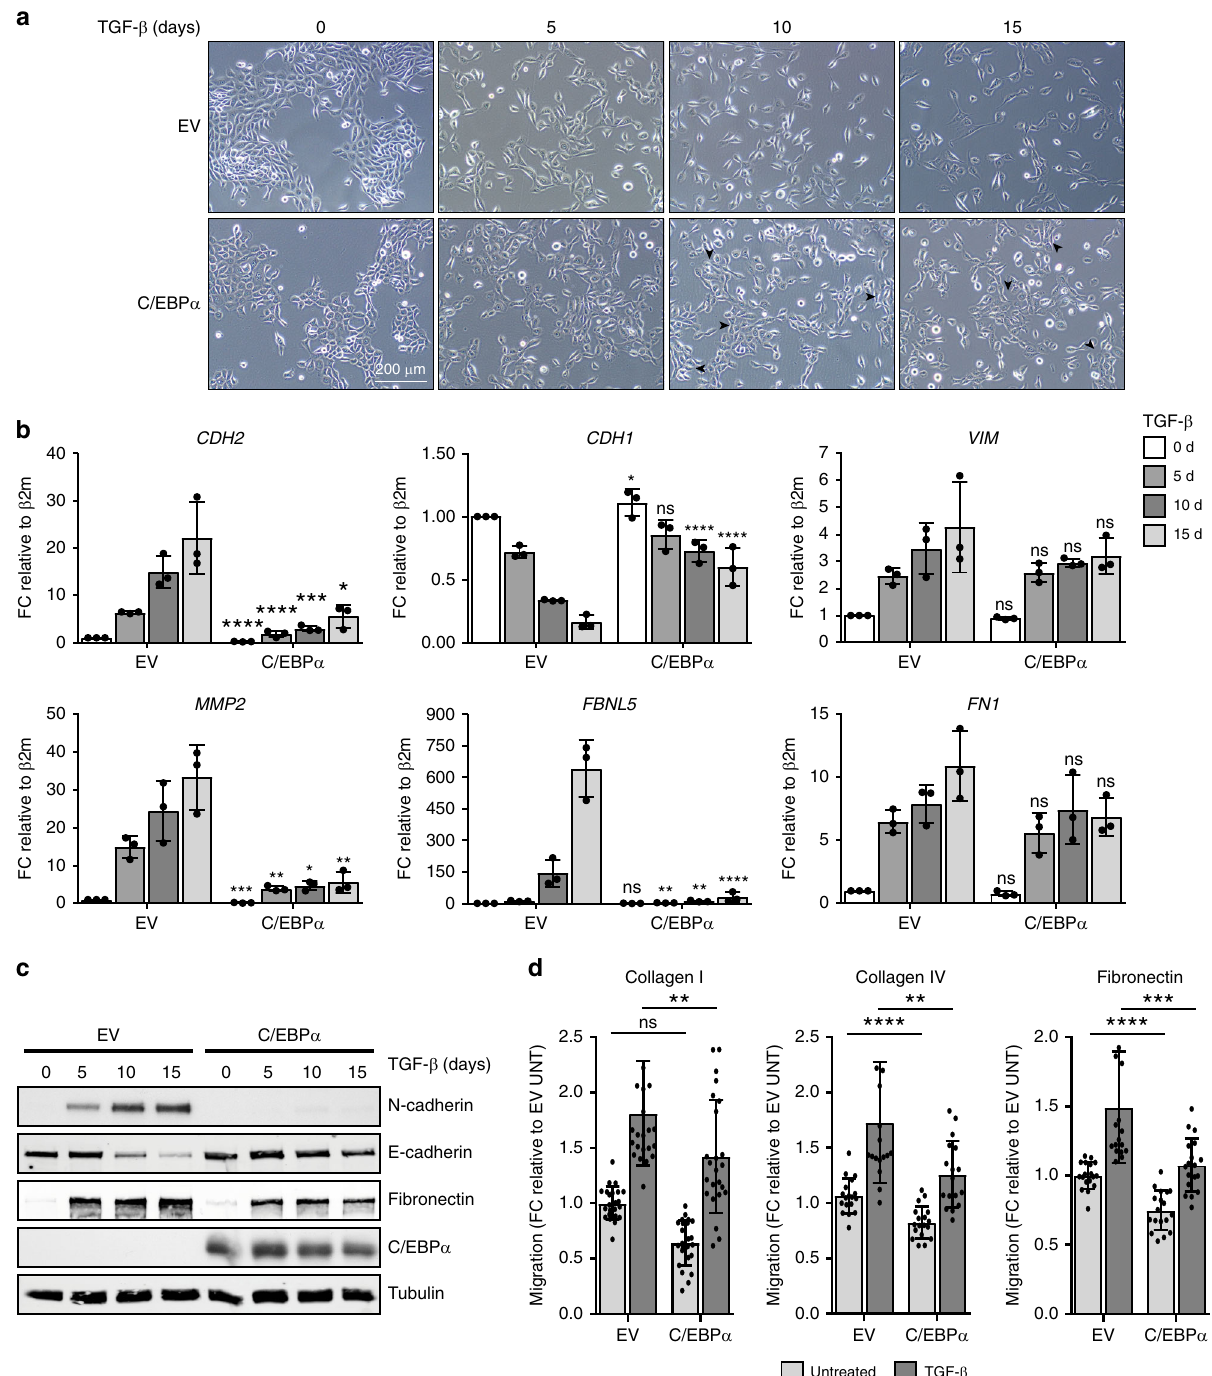
Fig. 4 Constitutive expression of C/EBP ɑ impairs TGF- β -induced EMT. a HMLE cells expressing empty vector (EV) or constitutive CEBPA were either left untreated or treated with 2.5 ng/ml of TGF- β for 0, 5, 10, or 15 days. Bright- fi eld microscopy images showing cell morphology during treatment. Data are representative of three independent experiments. Scale bar: 200 μ m. b qRT-PCR results displaying the expression levels of well-stablished EMT markers during TGF- β stimulation in the presence of CEBPA constitutive expression. Data represented as mean ± SD of three independent experiments. p -values were calculated using unpaired two-tailed Student ’ s t test. * p < 0.05, ** p < 0.01, *** p < 0.001, **** p < 0.0001. ns not signi fi cant. c Immunoblotting results showing the protein levels of well-characterized epithelial and mesenchymal markers during TGF- β signaling in the presence of CEBPA constitutive expression. Data are representative of three independent experiments. d Quanti fi cation of wound closure in HMLE cells expressing EV or C/EBP α in untreated and TGF- β treatment conditions using 24-wells coated with the indicated substrates. Data represented as mean ± SD of n = 18 – 24 independent biological replicates. p -values were calculated using unpaired two-tailed Student ’ s t test. ** p < 0.01, *** p < 0.001, **** p < 0.0001. ns not signi fi cant, d days, FC fold change, β 2m beta-2-microglobulin, UNT